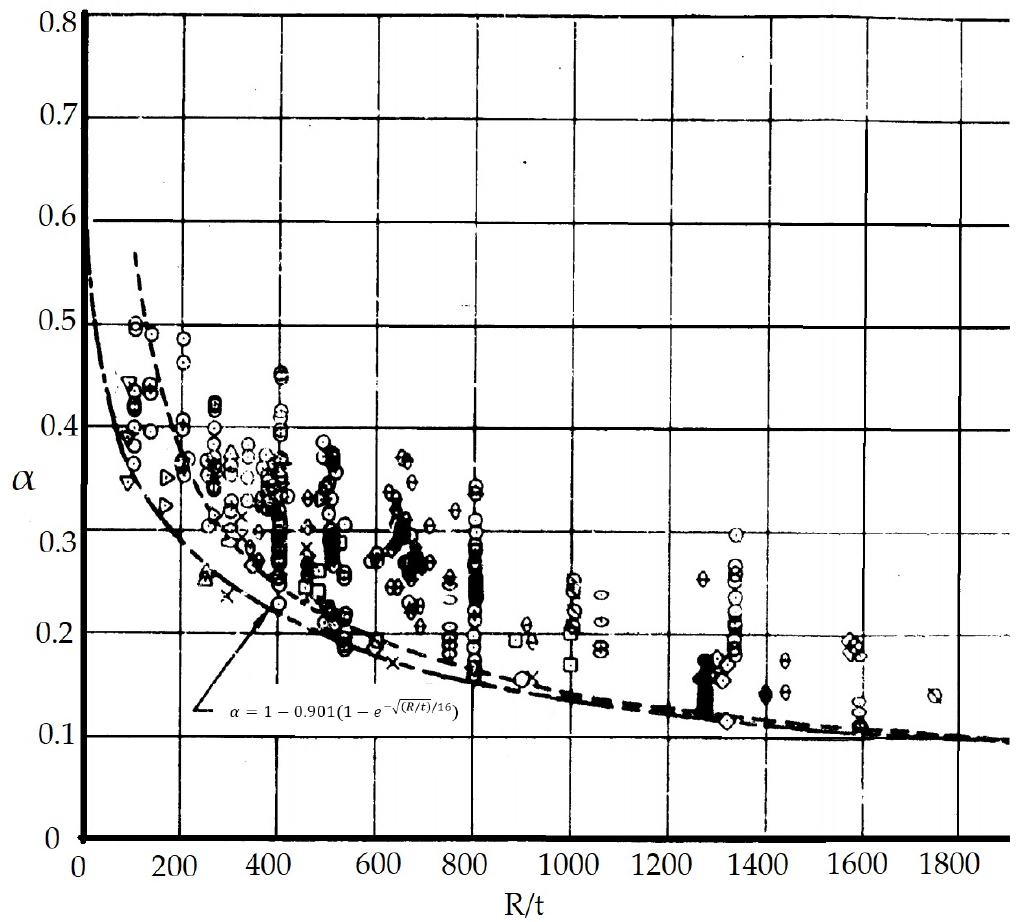
Figure 9. Experimental data [55,56] of the cylindrical shell on the knockdown factor according to the radius to thickness ration, R/t, under axial compressive loads, and a selected range of R/t from 0 to